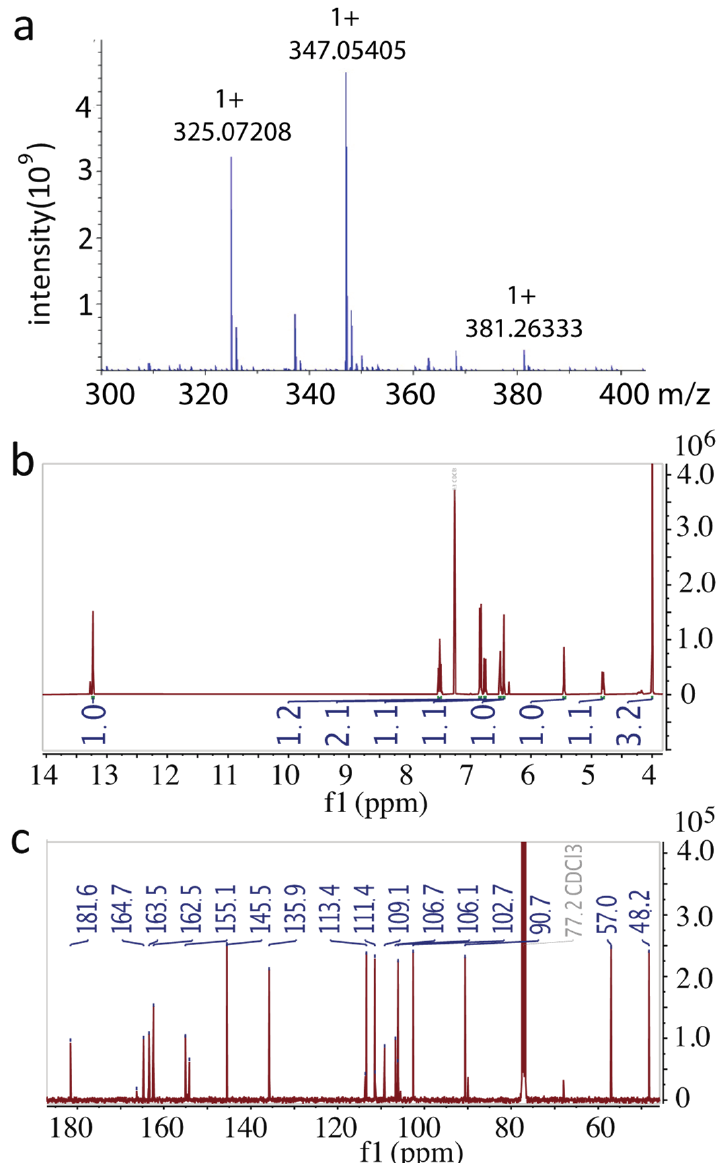
Figure 5. Structure identification of active compound. ( a ) Positive ion mode mass spectrum that showed 325.07208 [M + H] + and 347.05405 [M + Na] + . ( b ) 1 H NMR spectrum. ( c ) 13 C NMR spectrum.